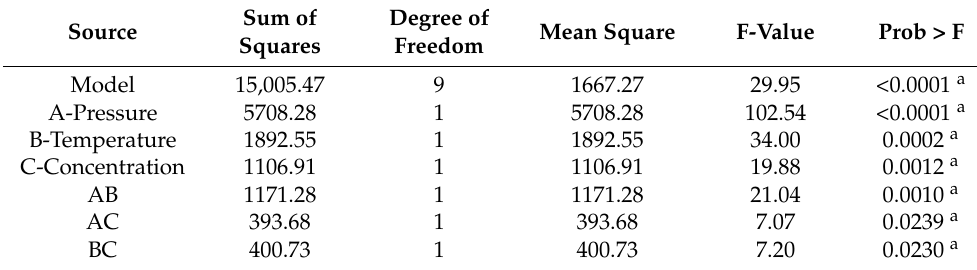
Table 4. Analysis of variance (ANOVA) for CH 4